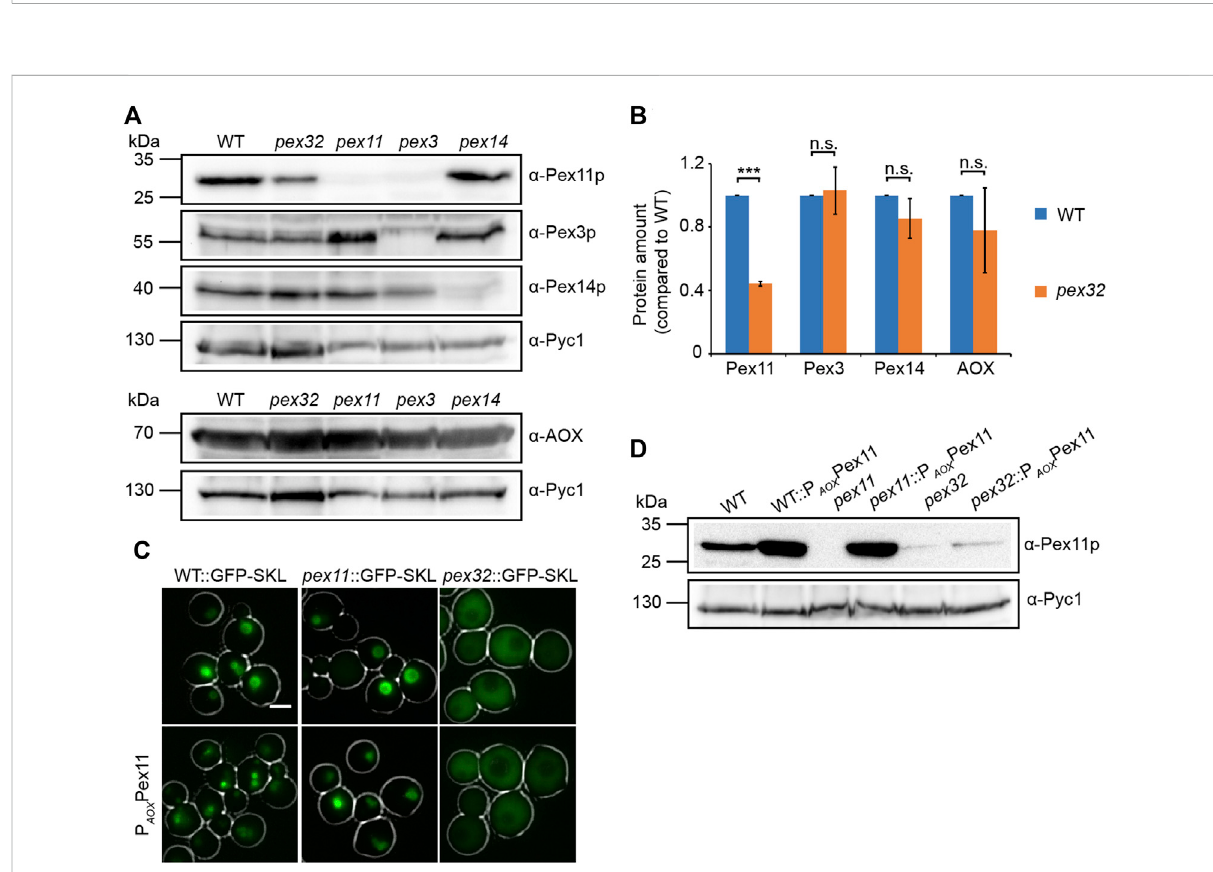
Pex11 levels are low in pex32 cells. (A) Western blot analysis and (B) quanti fi cation of indicated proteins in WT, pex32 , and indicated negative control cells grown for 16 h on methanol/glycerol. Blots were decorated with anti-Pex11p, anti-Pex3p, anti-Pex14p, anti-AOX, or anti-Pyc1 antibodies. Pyc1 was used as a loading control. In B, the protein levels of WT cells were set to 1. Signi fi cance indications: n. s. = p > 0.05, ***p = < 0.001. The error bars represent s.d . from three independent experiments. (C) FM images of WT, pex11 , and pex32 cells producing GFP-SKL grown on methanol/glycerol for 6 h. Scal e bar: 2 μ m. (D) Western blot analysis of the indicated strains grown on methanol/glycerol for 6 h. Blots were decorated with anti-Pex11p or anti-Pyc1 antibodies. Pyc1 was used as a loading